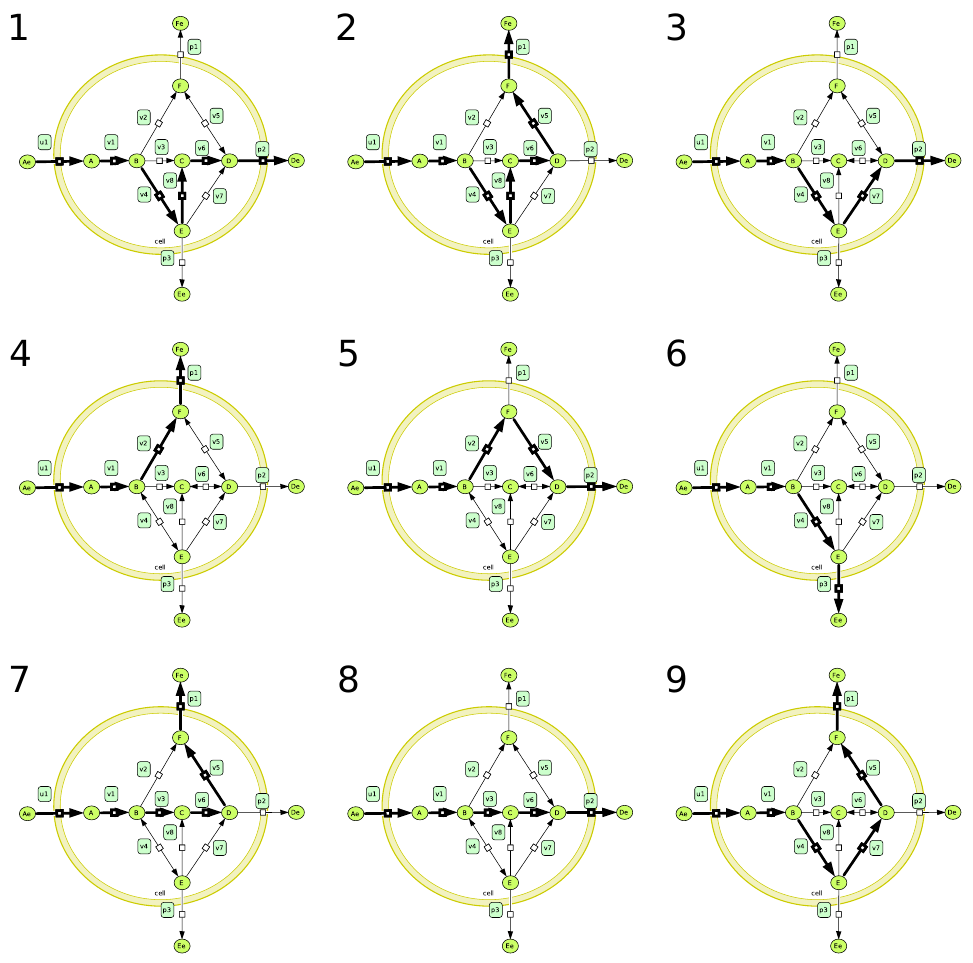
Figure 3. Graphical representation of the nine elementary flux modes of C defined by Equation (11). The bold lines represent the reactions that are active in each EFM. This figure was automatically drawn with EFMdraw